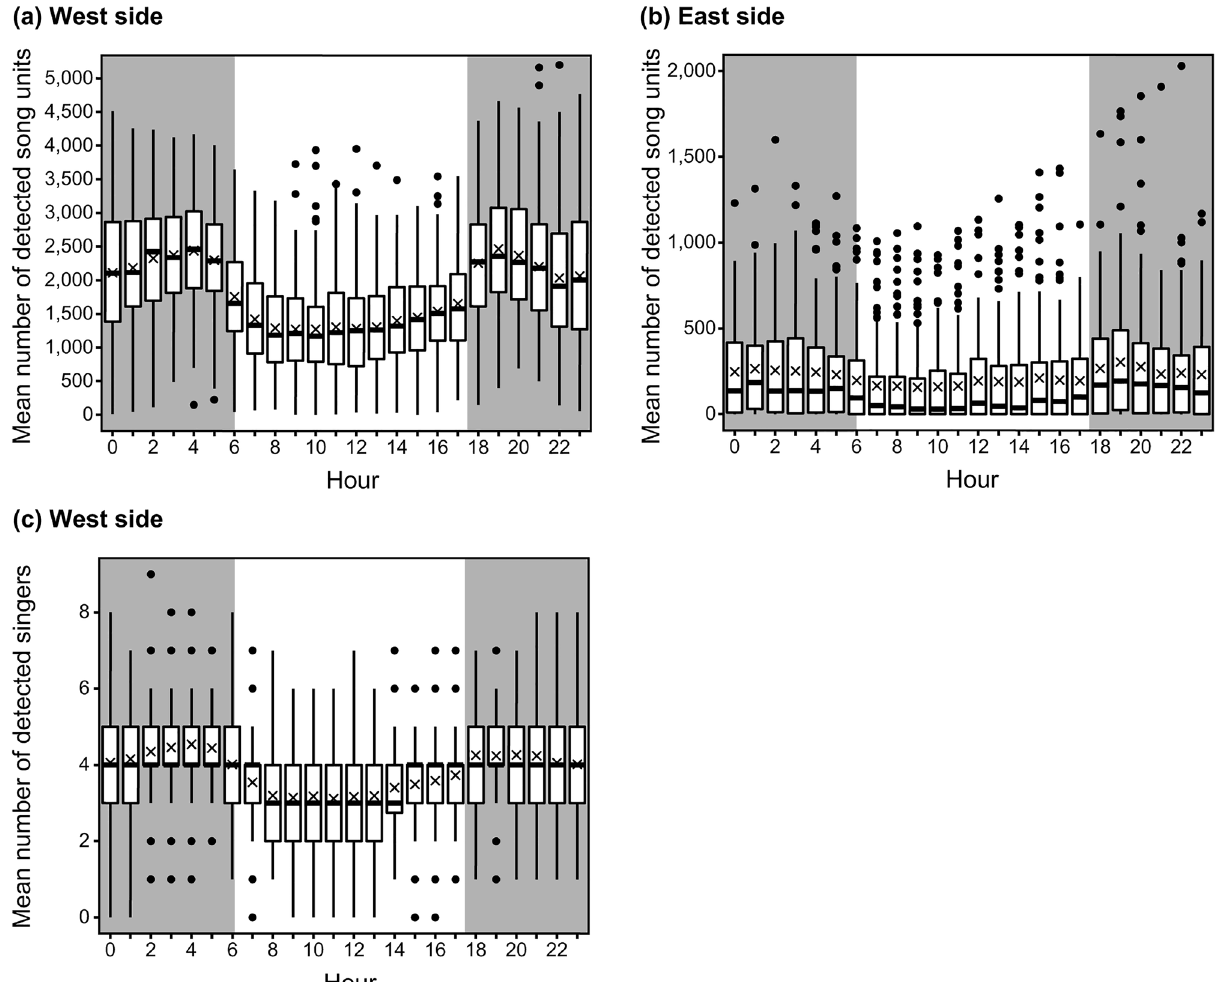
Figure 3. Diel variations in ( a ) the mean number of detected song units on the west side of Chichijima Island; ( b ) the mean number of detected song units on the east side of Chichijima Island; and ( c ) the mean number of detected singers on the west side of Chichijima Island. The lines in the middle of boxes represent the median, and the cross marks show the mean. The bottom and top of the boxes indicate the 25th and 75th percentiles. Whiskers represent 1.5 times the interquartile range, and dots outside of the whiskers represent outliers. Grey and white areas indicate night and daytime, respectively. Significant diel variations were observed on both sides of the island (Kruskal–Wallis rank sum test, all p < 0.001). Note that the y-axis scale is different in each